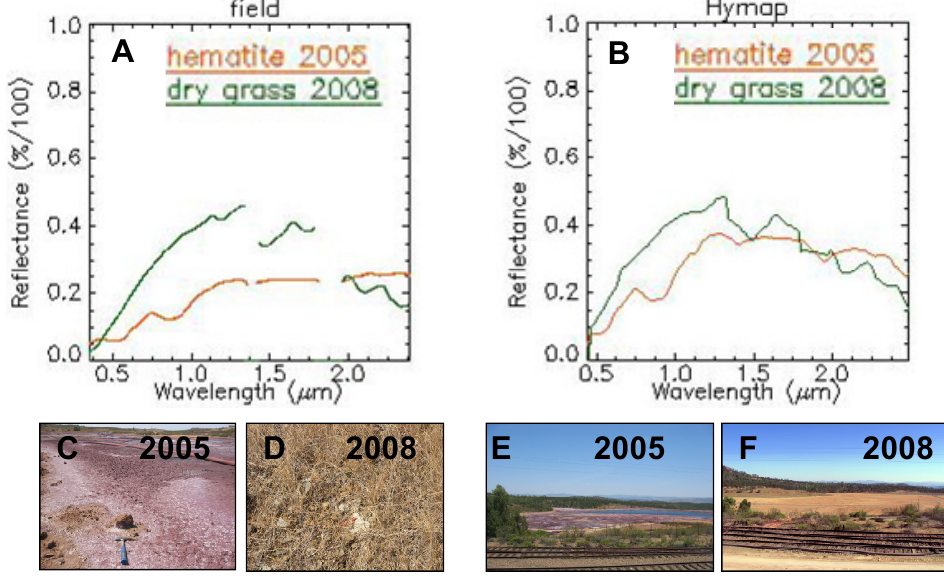
Figure 4. Ash dam. ( A ) Field spectra from dominant hematite in the ash dam in 2005 and dry grass in 2008 covering the former ash dam. ( B ) HyMap spectra from dominant hematite in the ash dam in 2005 and dry grass in 2008 covering the former ash dam. ( C ) Detail of dominant hematite crusts covering the ash dam in 2005, with spectra in A. ( D ) Detail of dry grass covering the recovered former ash dam in 2008, with spectra in A. ( E ) View of dominantly hematitic crusts covering the ash dam in 2005. ( F ) View of the dry grass covering the former ash dam in 2008, with operator measuring